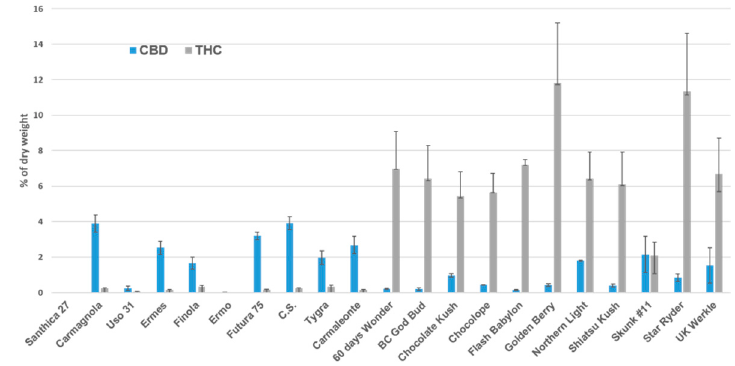
Figure 1. Cannabidiol (CBD) and tetrahydrocannabinol (THC) content found in drug-type and hemp varieties selected for the experiment.